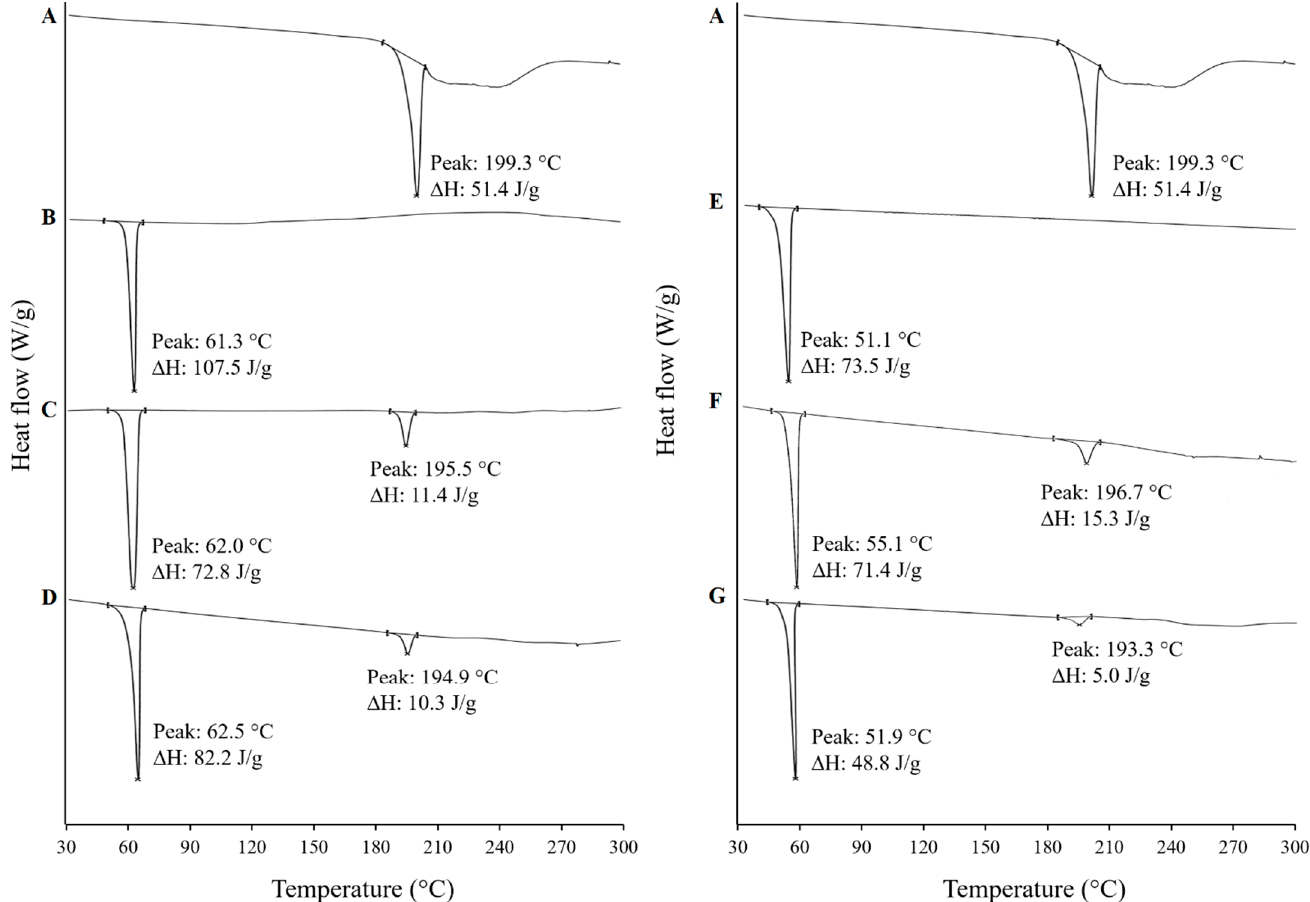
Figure 3. Differential scanning calorimetry (DSC) thermograms of ( A ) Supplied FFH, ( B ) Supplied PEG 20,000, ( C ) Physical mixture of FFH with PEG 20,000 at 1:4 ratio (PM-FP20K (1:4) ), ( D ) Solid dispersion of FFH with PEG 20,000 at 1:4 ratio (SD-FP20K (1:4) ), ( E ) Supplied poloxamer 188, ( F ) Physical mixture of FFH with poloxamer 188 at 1:4 ratio (PM-FP188 (1:4) ), ( G ) Solid dispersion of FFH with poloxamer 188 at 1:4 ratio (SD-FP188 (1:4) ).